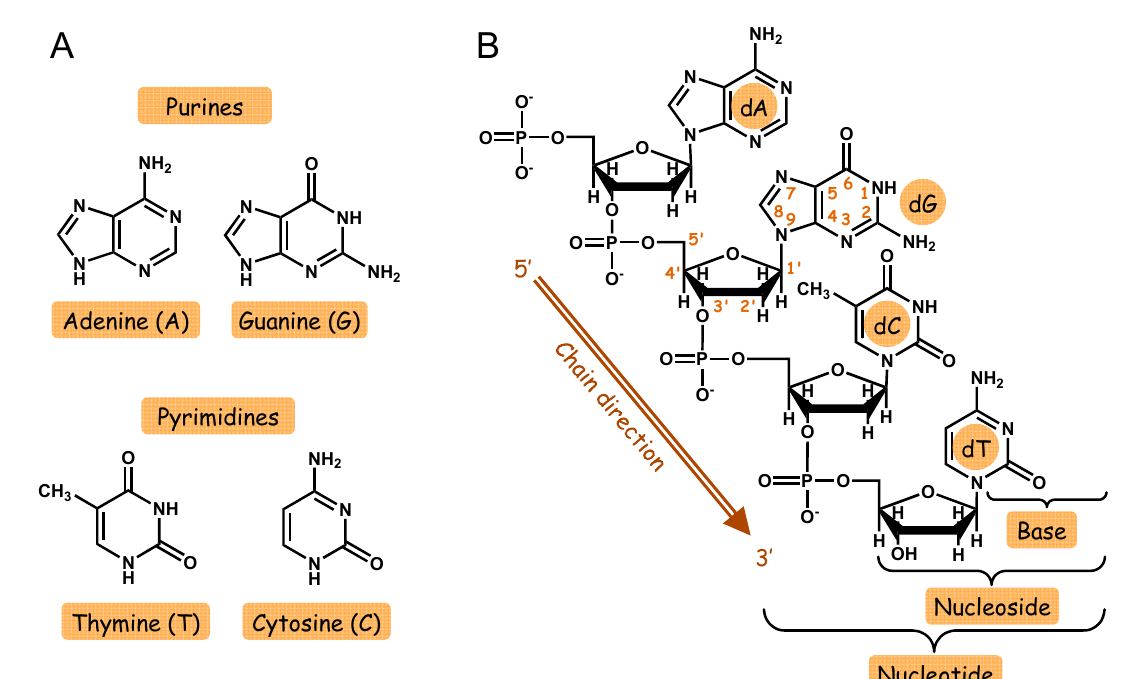
Scheme 1. ( A ) Chemical structures of the deoxyribonucleic acid (DNA) aromatic bases, and ( B ) DNA fragment with the nucleosides sequence deoxyadenosine (dA), deoxyguanosine (dG), deoxythymidine (dT) and deoxycytidine (dC) linked by 3’,5’ -phosphodiester bonds. Chain direction is from 5 ′ to 3 ′ end. Atom numbering is presented in the nucleotide unit 5 ′ -guanosine monophosphate (GMP).